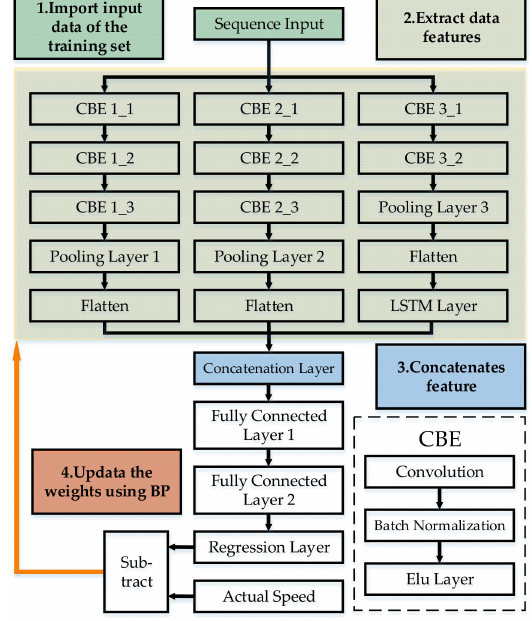
Figure 5. The architecture of